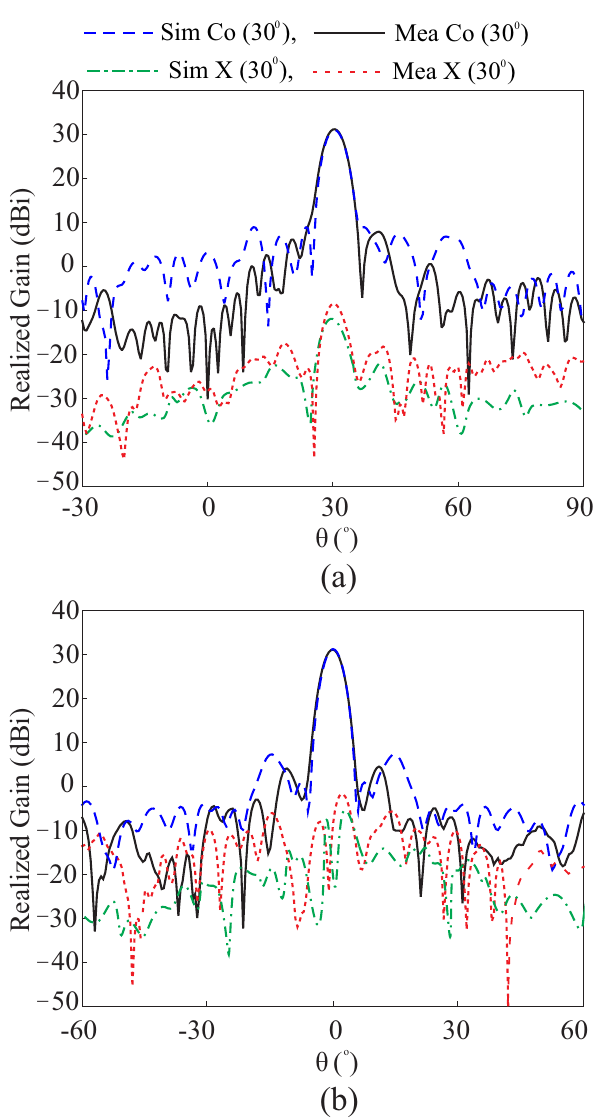
Figure 9. Comparison of the simulated and measured co-pol patterns, and measured x-pol patterns at 11.725 GHz. ( a ) Azimuthal plane. ( b ) Elevation plane.